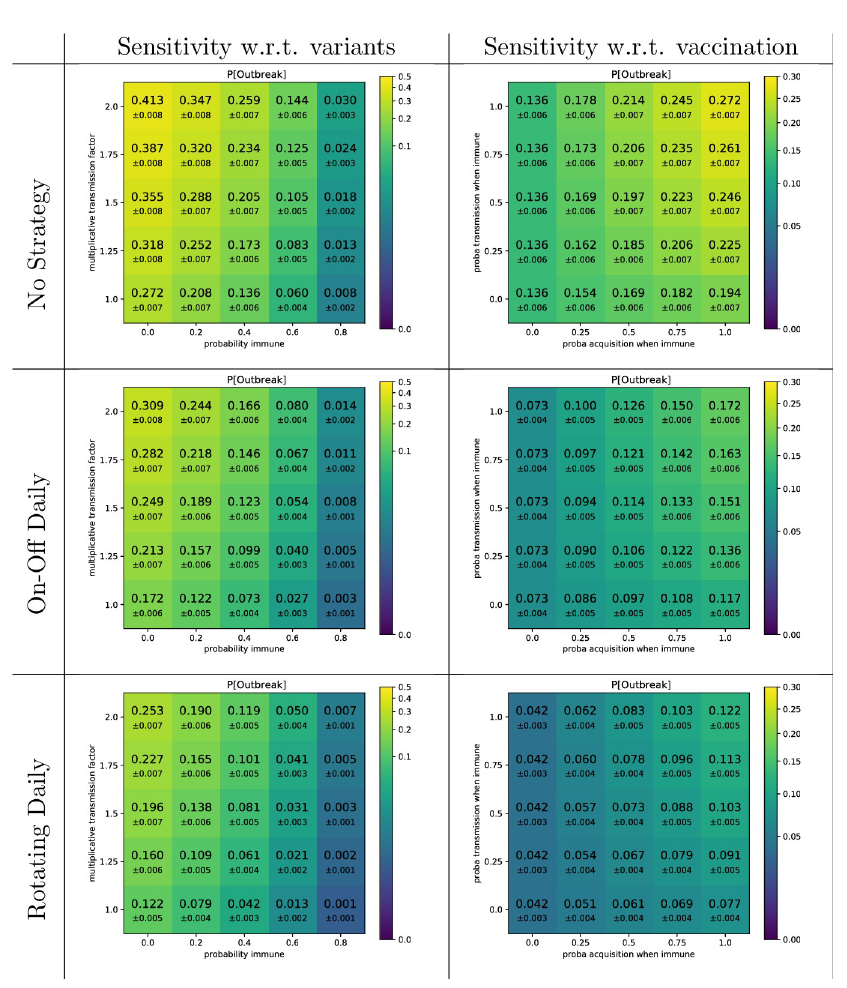
Fig 6. Impact of strategies on outbreak probability in a partially immunized population subject to the circulation of variants, simulated in the high school contact network. In our baseline scenario with no strategy, the probability of outbreak equals 27.2%. Each row reproduces results under specific strategies. In the left column, we study the sensitivity of this quantity with respect to potential variants showing increased transmission capacity compared to the reference strain (multiplicative factor on the y -axis), by assuming that such variants would circulate in partially immune populations (percentage of immune people on the x -axis); immune people do not get infected nor transmit the virus. In the right column, we study the sensitivity with respect to vaccination: we assume that 40% of the population is partially immune and that partially immune individuals are less likely to be infected and to contaminate others when infected. On the x -axis, we vary the relative probability of becoming infected and, on the y -axis, the relative probability of transmission by an infected partially immune individual. These results assume that patient 0 is never